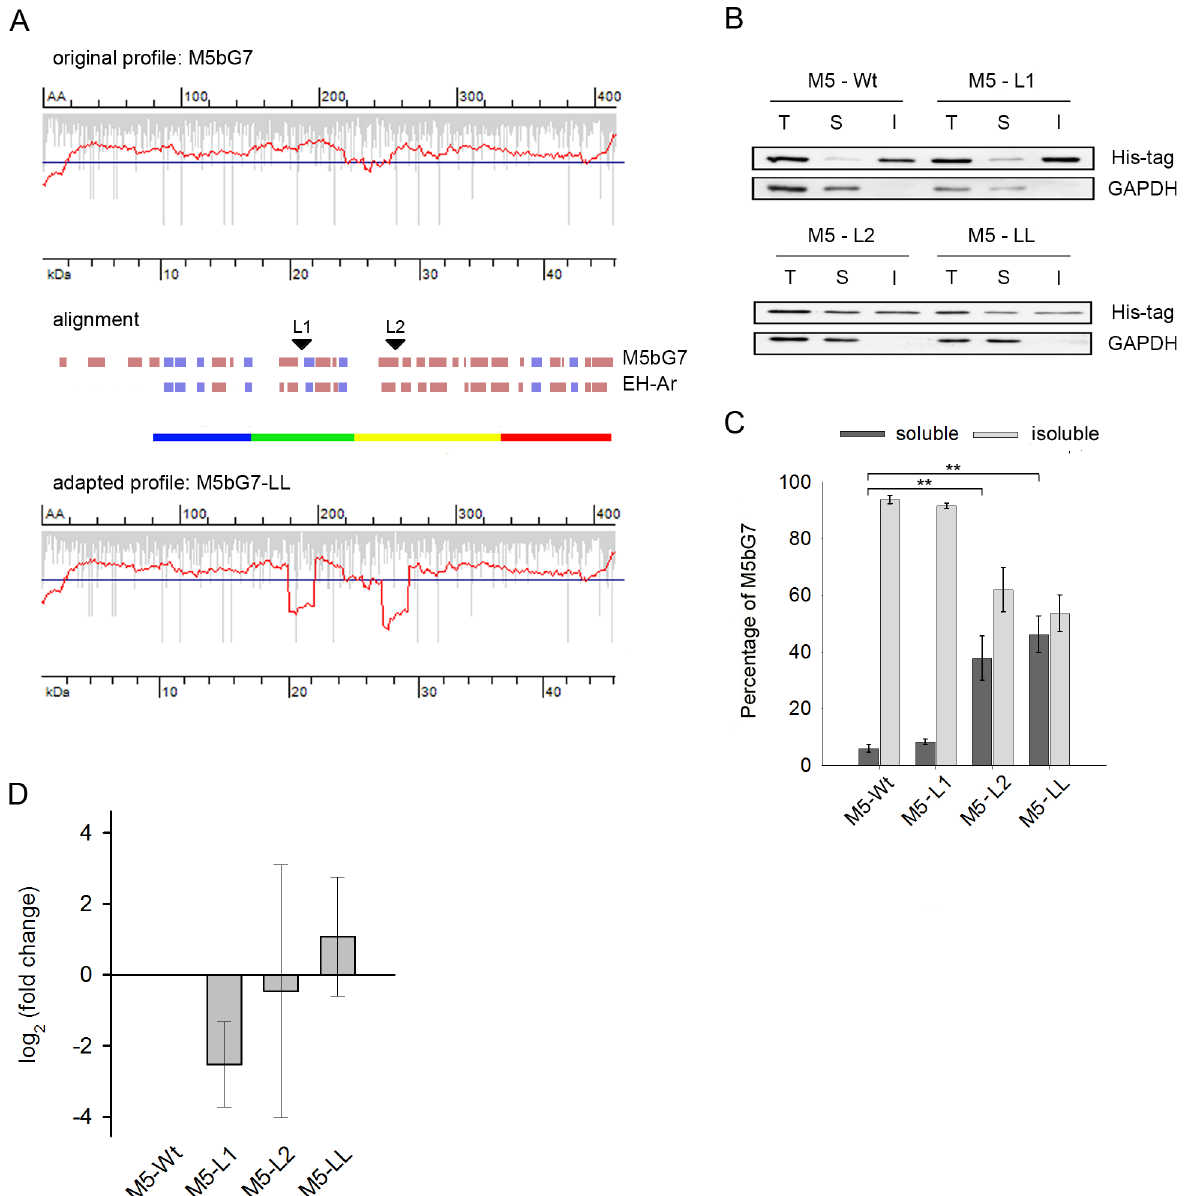
Fig 2. Introducing translational attenuation sites into the EH M5bG7 sequence enhances its solubility. (A) Translation profile of wild-type M5bG7 (top diagram, original profile) and upon introduction of translational attenuation sites (bottom diagram, adapted profile) in E . coli . Secondary structure alignment ( β -sheets — blue bars, α -helices — dark red bars, uncolored empty space — linking structural elements) of M5bG7 to EH-Ar to identify regions for introduction of slow-translating stretches (indicated with arrows). The domains in M5bG7 were delineated based on the domain architecture of EH-Ar represented in the color code as in Fig 1A. Note the longer N-terminal domain of M5bG7 than that of EH-Ar. (B) Representative immunoblot of M5bG7 (abbreviated M5) variants. L1 (Leu 189, CUC/A, numbering is according to the M5bG7 sequence) and L2 (Leu 257, CUG/A) denote the synonymous exchange of a fast- translating Leu codons to Leu CUA in the first and second attenuation, respectively, and LL (Leu189, CUC/A, Leu257, CUG/A) in both simultaneously. T, total protein, S, soluble and I, insoluble fraction. GAPDH served as loading control. (C) Quantification of immunoblots of three biological replicates ± SEM. ** , p < 0.01, Tukey ’ s test. For details refer to the legend of Fig 1. (D) Quantification of mRNA levels by qRT-PCR of the M5bG7 variants. Values were normalized to GAPDH mRNA expression, represented as a fold-change to the wild-type mRNA and are means ± SEM (n =